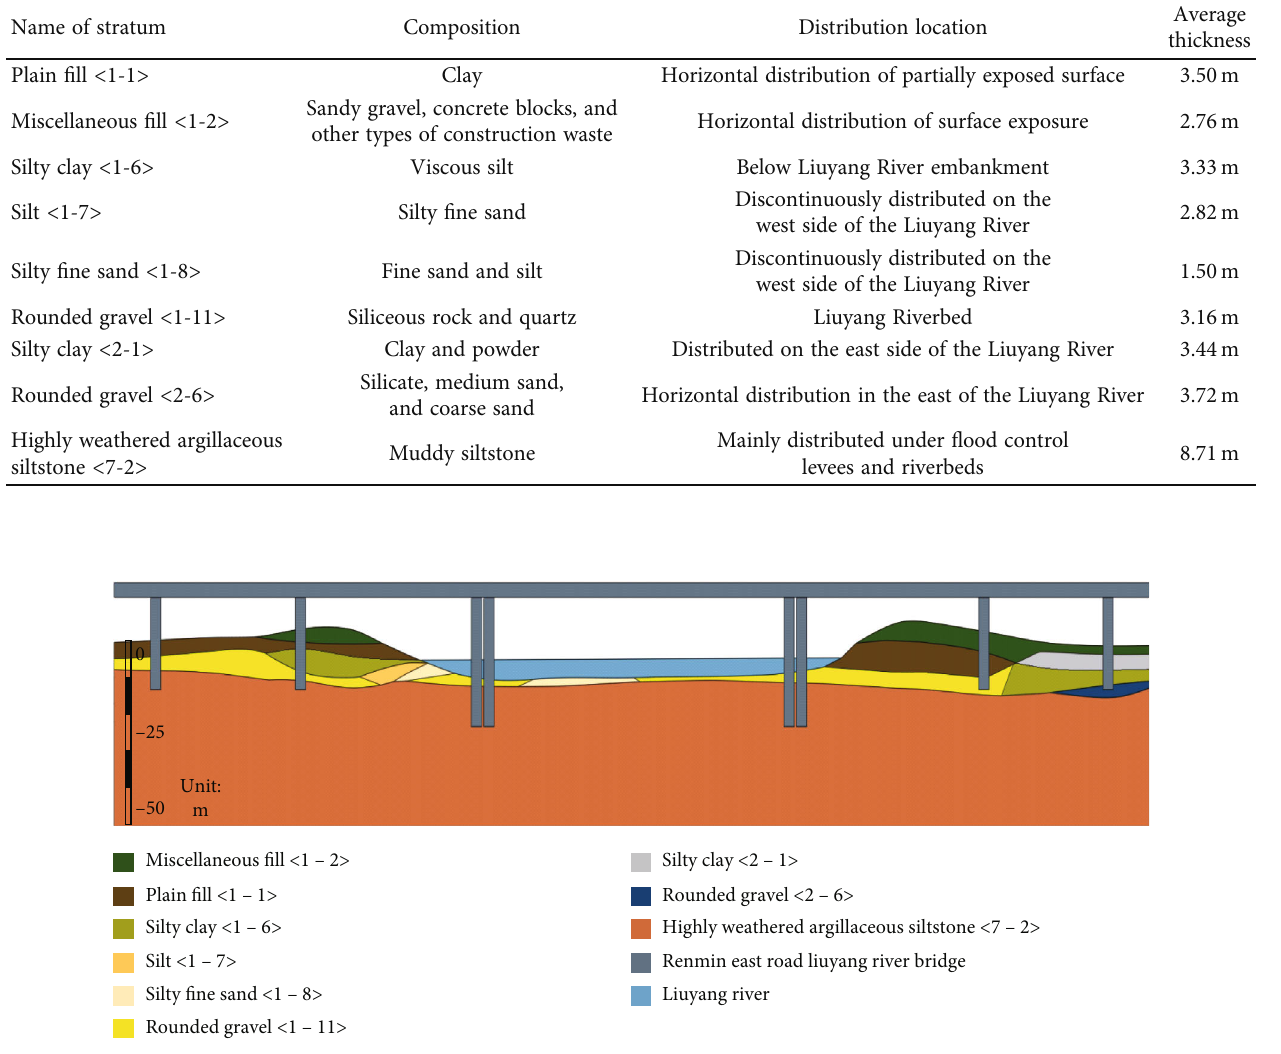
Figure 2: Engineering geologic